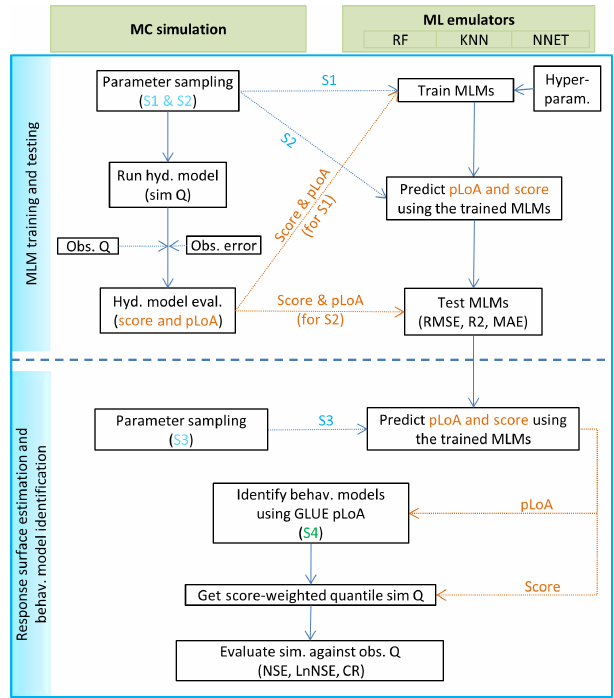
Figure 2. Schematic overview of the MLM training and testing, response surface prediction using the MLMs, and the identification of behavioural models using the coupled MLM and GLUE